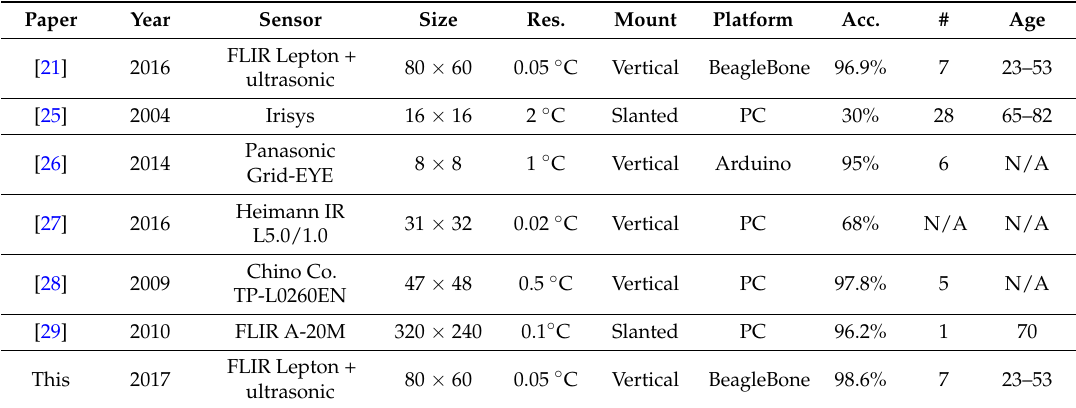
Table 12. Thermal array approaches for fall